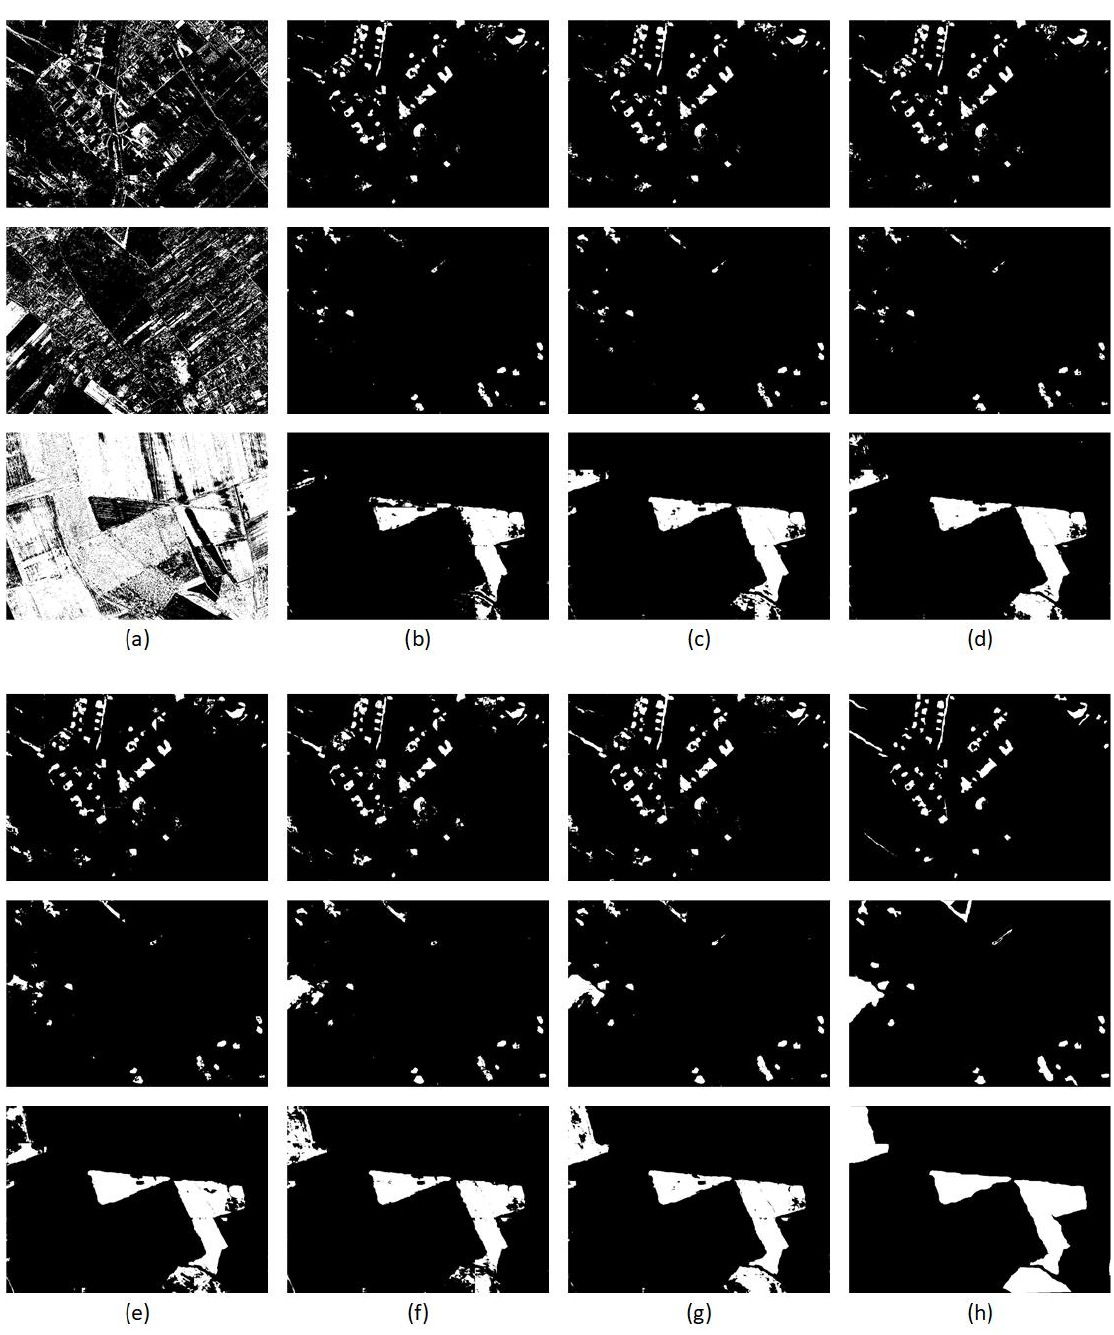
Figure 7. The change detection results of comparative methods for the 3 test image pairs of the SZTAKI benchmark shown in Figure 5: ( a ) CVA, ( b ) SVM, ( c ) CNN, ( d ) GAN, ( e ) DSCN, ( f ) SCCN, ( g ) our DLSF, ( h ) reference map.